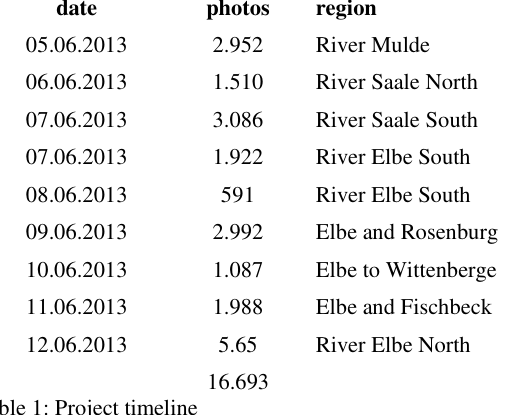
Table 1: Project timeline The flood areas were so large that many parallel flight strips were necessary.